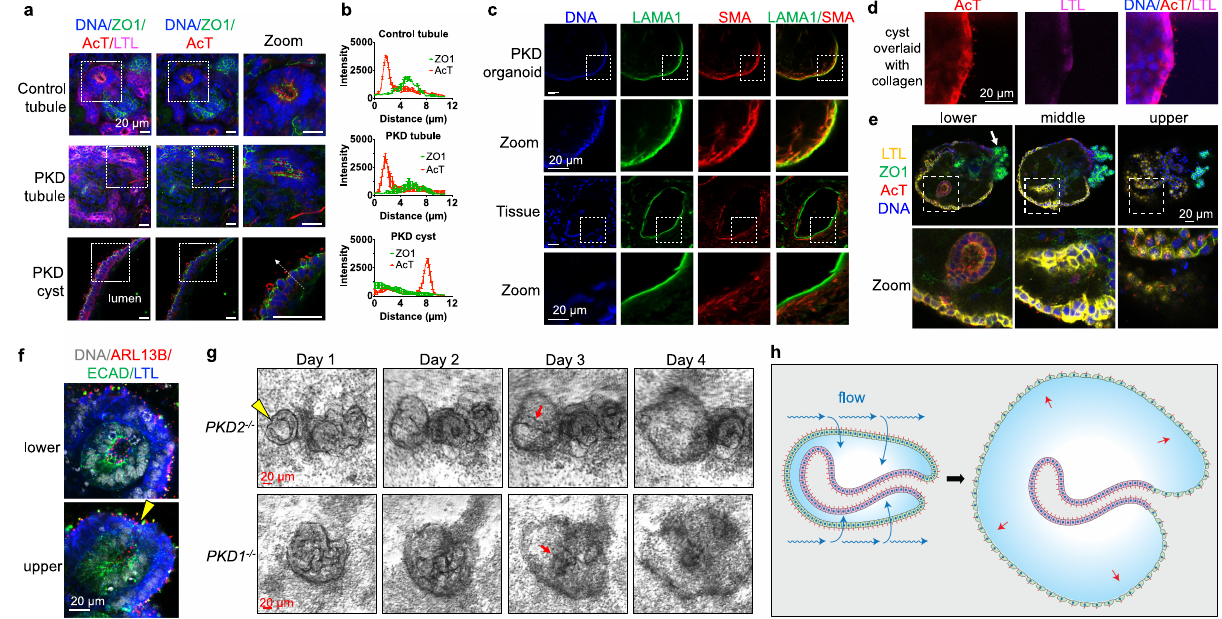
Fig.5|PKDcystsformviaexpansionofoutwards-facingepithelium.a Confocal immuno fl uorescence images of cilia (acetylated α -tubulin, abbreviated AcT) and tight junctions (ZO-1)inproximaltubules (LTL)of PKD and non-PKDorganoids, as well as in PKD cyst lining epithelial cells. Dashed arrow indicates how line scans were drawn. Images are representative of three independent experiments. b ZO1 and AcT intensity pro fi les in cysts vs. organoids. Line scans were drawn through cilia from lumen to exterior of structures. (mean±s.e.m. from n =5 line scans pooled from three organoids or cysts per condition from three independent experiments). c Fluorescent images of stromal markers in PKD organoids com- paredtohumankidneytissuefromafemalepatient50yearsofagewithautosomal dominant PKD. Scale bars 20 µ m. d Fluorescent images of cysts after having been overlaid with collagen. Images are representative of three independent experi- ments. e Z-stack confocal images of early (day 30) PKD organoid cyst in adherent